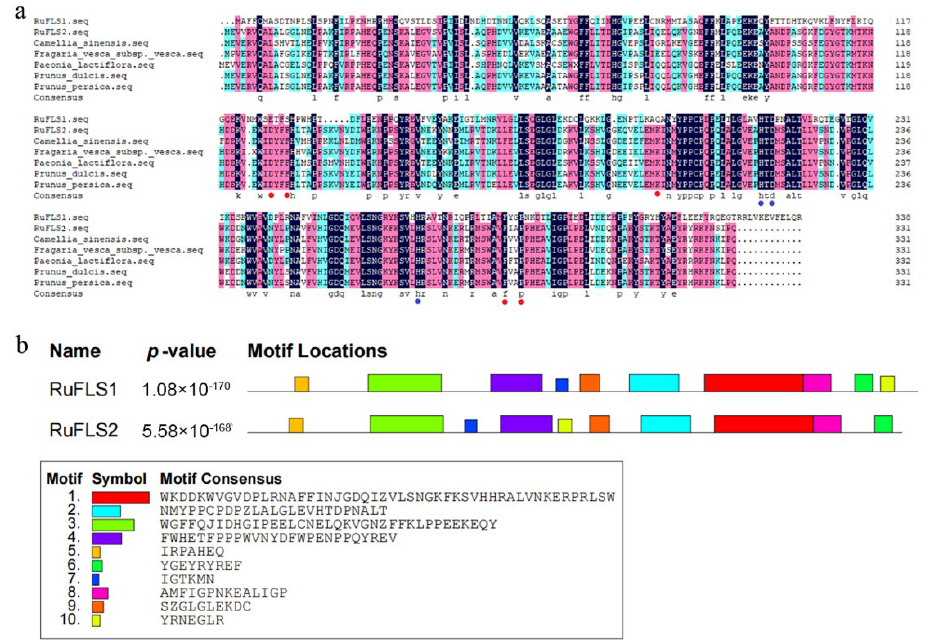
Figure 2. Multiple sequence alignment and motifs of FLS amino acid sequences. ( a ) Multiple sequence alignment of FLS amino acid sequences in different plants. ( b ) Conserved domains or motifs in the RuFLSs.